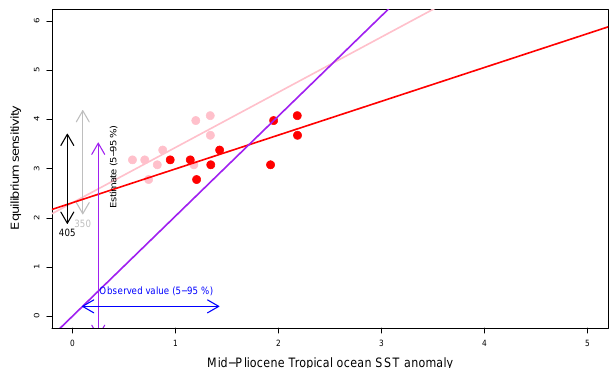
Figure 3. Investigating the sensitivity to structural uncertainties. Bold colours show original result; pink and grey show estimated result if 350ppm CO 2 were used. Purple shows regression result with zero constant